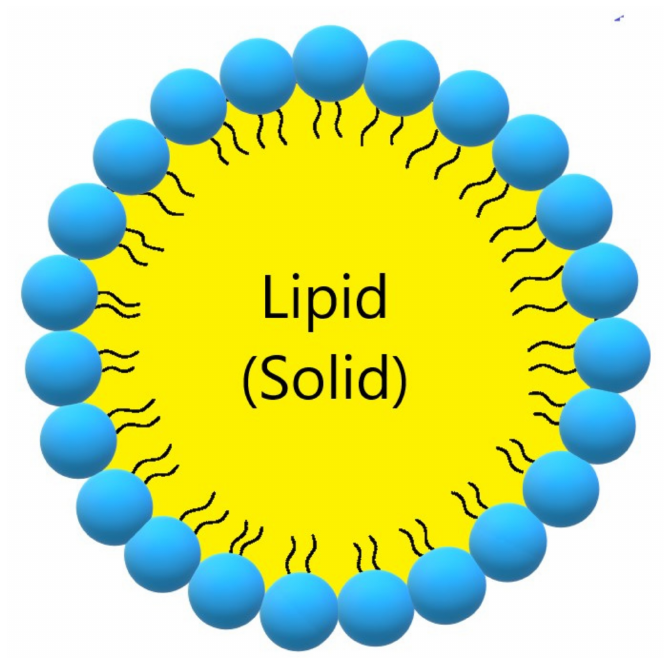
Figure 3. Schematic representation of solid lipid